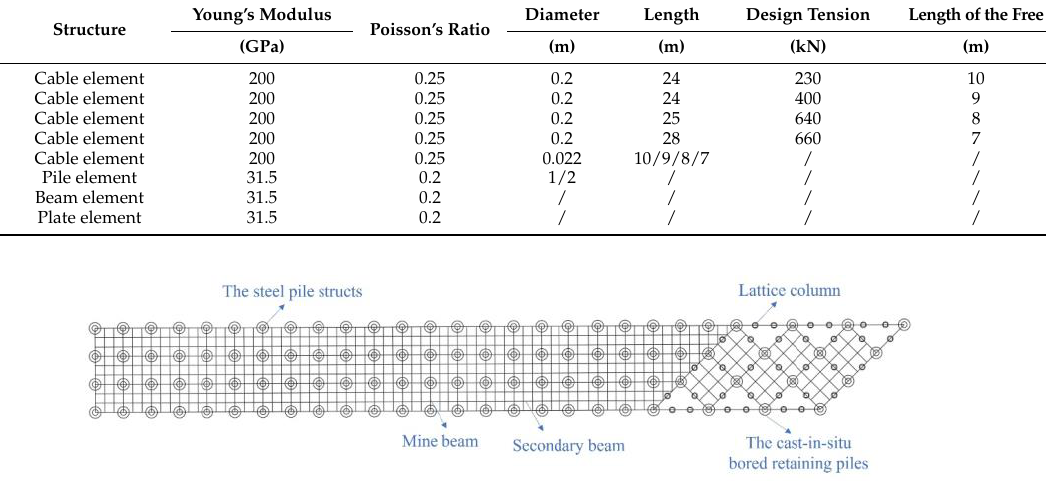
Figure 4. Layout of the main structure system in Area B. Table 2. Physical and mechanical parameters of structures.